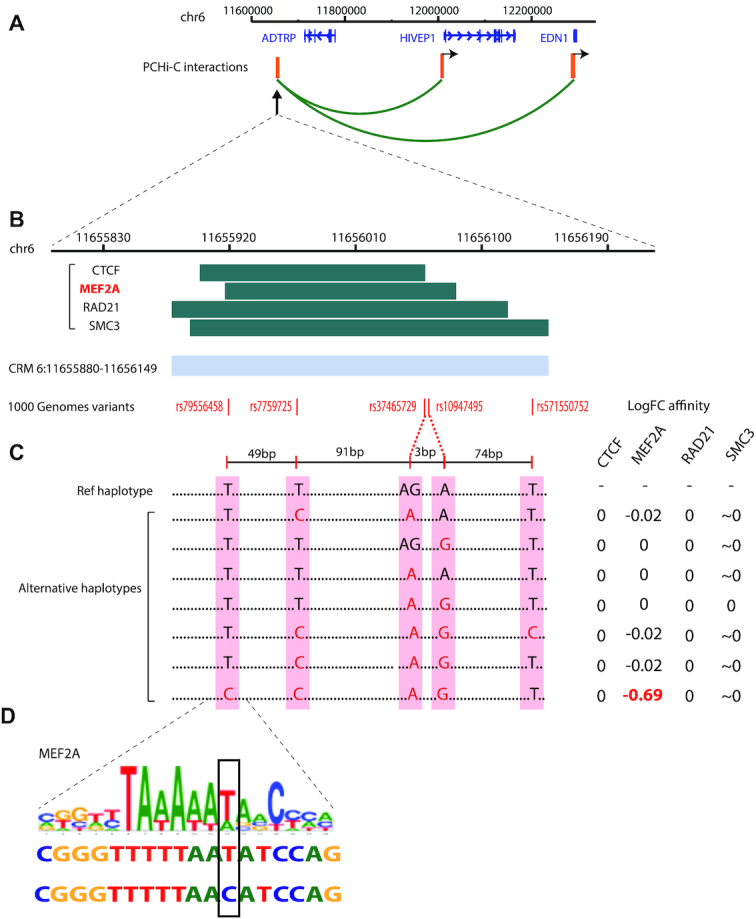
Variation in TF binding affinity at a distal CRM. (A) Chromosomal interactions (green arcs) of a distal CRM on chromosome 6 (left) with two downstream genes in the LCL GM12878 detected by PCHi-C (49,61). HindIII restriction fragments containing the CRM (left) and baited promoters (two fragments on the right) are shown in orange. (B) Top: the ChIP-seq peaks from ENCODE (4) detected at this CRM (dark green) and used to define its boundaries (light blue). Bottom: the positions of 1000 Genomes Project SNPs within the CRM (red). (C) CRM haplotypes detected in 1000 Genomes Project (left) and changes in the affinity for the bound TFs at them with respect to the reference haplotype estimated using the biophysical model (39). (D) The MEF2A motif instance underlying the highest change in the affinity of this TF at the CRM. Top: motif logo; bottom: the reference and alternative haplotypes for this instance.